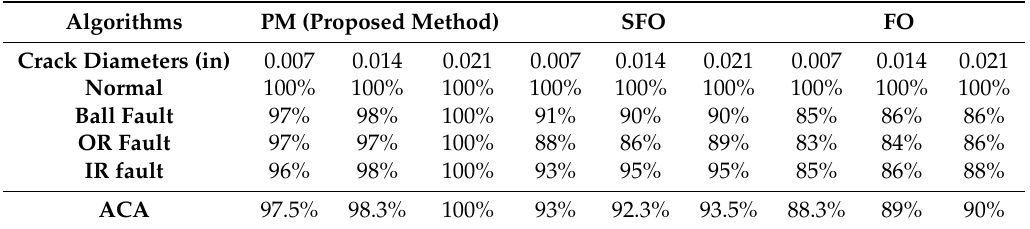
Table 6. The single fault diagnosis accuracy for 3 hp torque load.